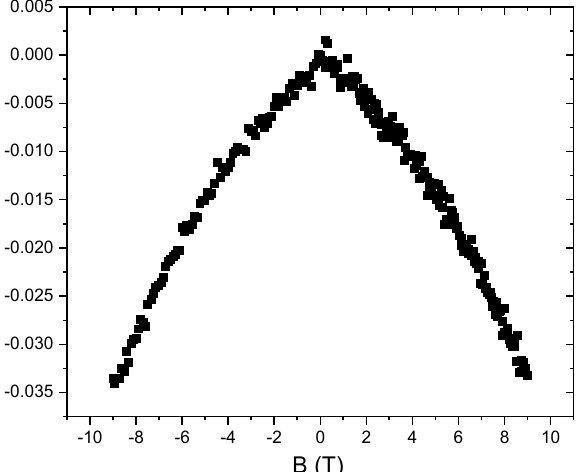
Figure 6. Magnetoresistance of compound 1 under a sweet rate of 20 Oe s − 1 at the temperature of 30 K.